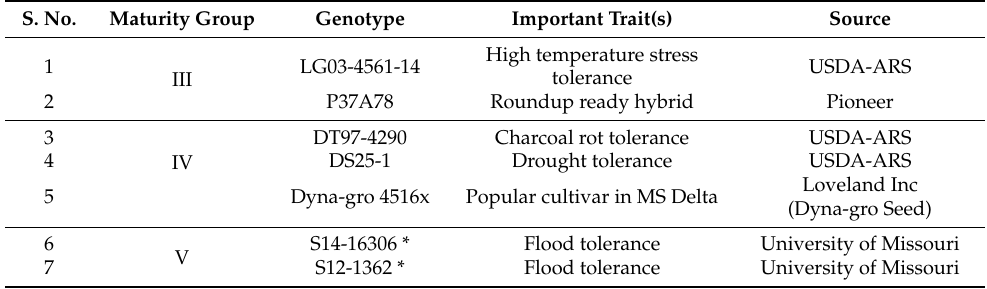
Table 1. Key characteristics of the soybean cultivars and their maturity groups used in the study. S. No.